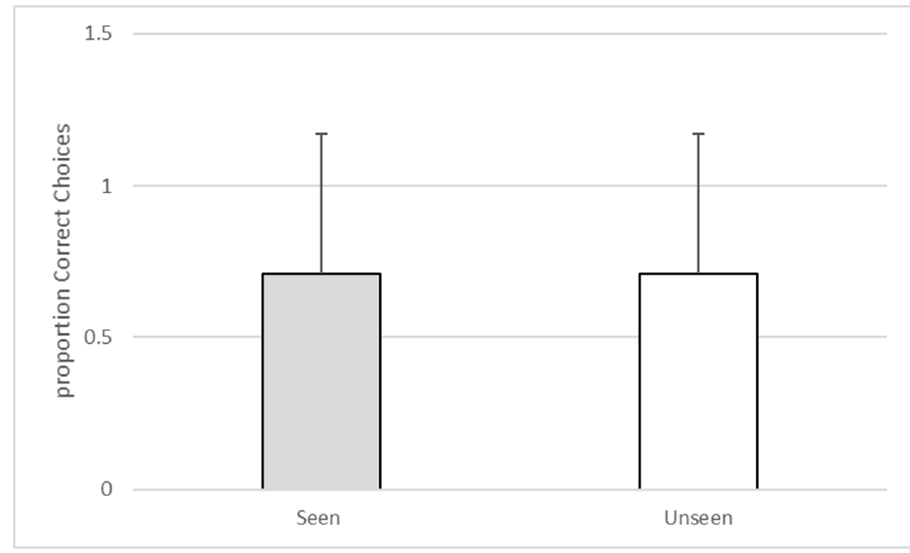
Figure 3. The proportion of correct choices during seen versus unseen trials during Experiment 1.